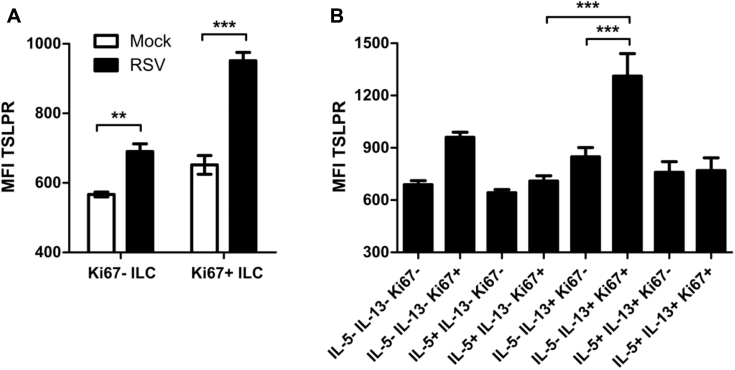
TSLPR expression in Ki67+ and Ki67− subsets of ILCs at day 4 after RSV infection. WT mice were infected with 3 × 106 PFU of RSV strain 01/2-20, and lungs were harvested for flow cytometry. A, MFI of TSLPR expression determined by means of flow cytometry at day 4 after RSV infection stratified by Ki67 expression status. B, Subset analysis of ILCs stratified by Ki67 expression status in RSV-infected mice at day 4 after infection. Data are plotted as means ± SEMs. For Fig E3, A and B, n = 5 mice per group. **P < .01, and ***P < .001, 1-way ANOVA.